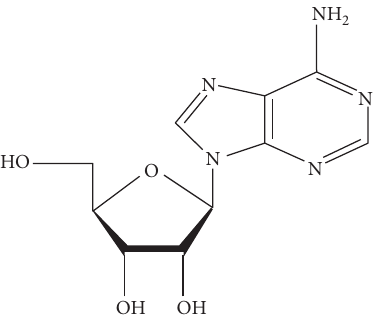
Figure 1: Chemical structure of